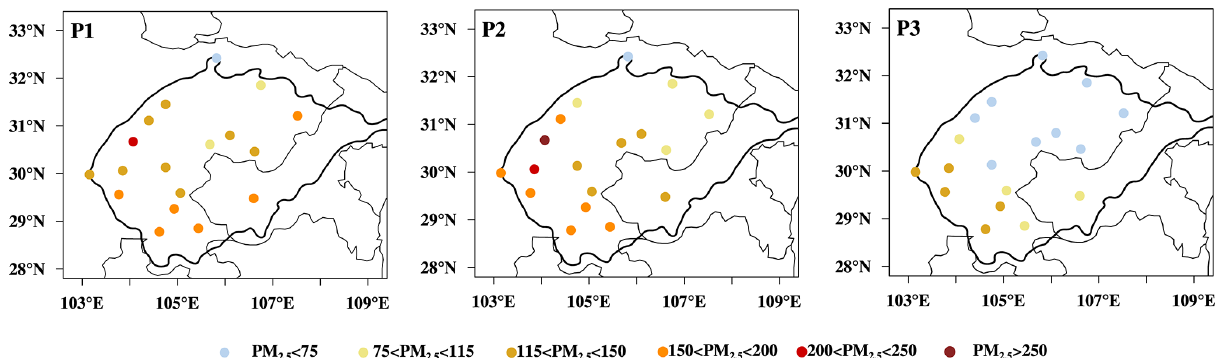
Figure 4. Spatial distributions of observed surface PM 2 . 5 concentrations in the SCB averaged in the formation, maintenance, and dissipation periods, P1, P2, and P3 (Fig. 2b), respectively, of the heavy haze pollution episode during 2–7 January